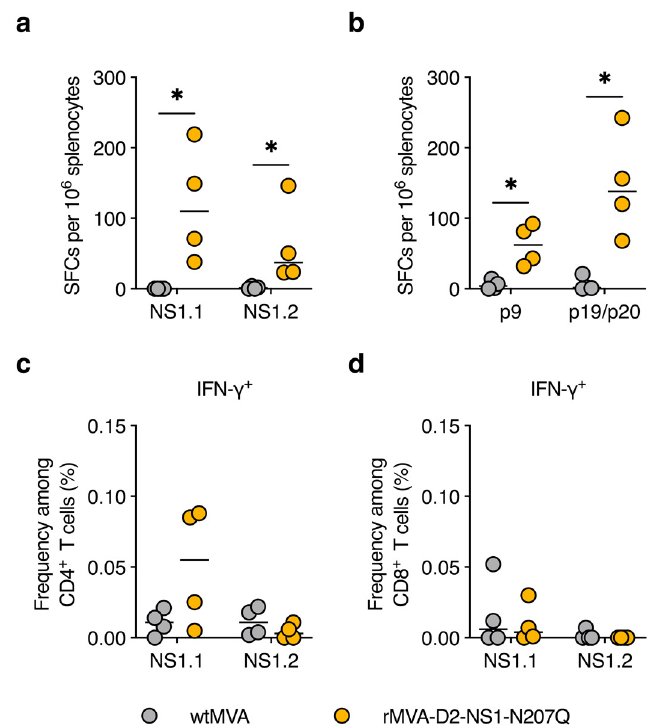
Figure 4. rMVA-D2-NS1-N207Q induces NS1-specific CD4 + T-cell responses in mice. Same mouse experiment as in Figure 3. Spleens were harvested on day 56 and splenocytes were restimulated with overlapping peptide pools NS1.1 or NS1.2 ( a , c , d ), or individual NS1-derived peptides covering known immunodominant epitopes ( b ). ( a , b ) Numbers of IFN- γ –producing cells were quantified by ELISpot. Data were DMSO background–subtracted and are expressed as spot-forming cells (SFCs) per 10 6 splenocytes. ( c , d ) Frequencies of IFN- γ –producing CD4 + T cells ( c ) and CD8 + T cells ( d ) were measured by flow cytometry. Each data point represents one mouse and short horizontal lines represent medians. *, p < 0.05 (Mann–Whitney U test).